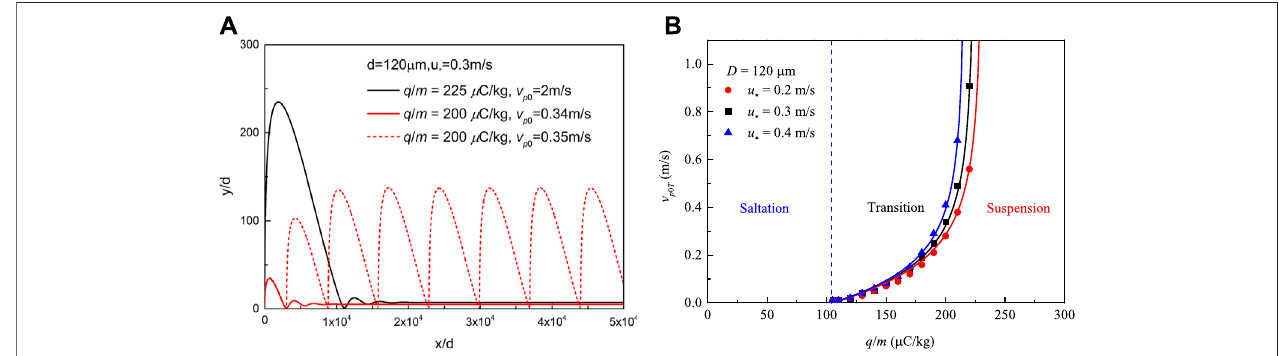
FIGURE 8 | The transition of particle saltation to low-level suspension. (A) Examples of particle trajectories at the transition from saltation to suspension as in fl uencedbydifferentinitialvertical velocities and charge-to-mass ratios. (B) Three regimesarede fi ned bytwocharge-to-mass ratiothreshold values,inwhichthelower threshold value is a constant of 105 μ C/kg for 120 μ m particles while the upper threshold value is affected by friction velocity and initial vertical velocity. The v p 0 T is the threshold of initial vertical velocity needed for the particle to transit from saltation to suspension. The solid line is fi tted by Eq. 17.